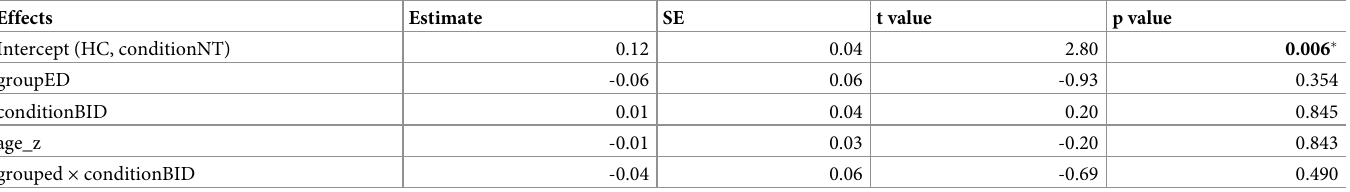
Table 6. Random effects linear regression for MB score (collected data).